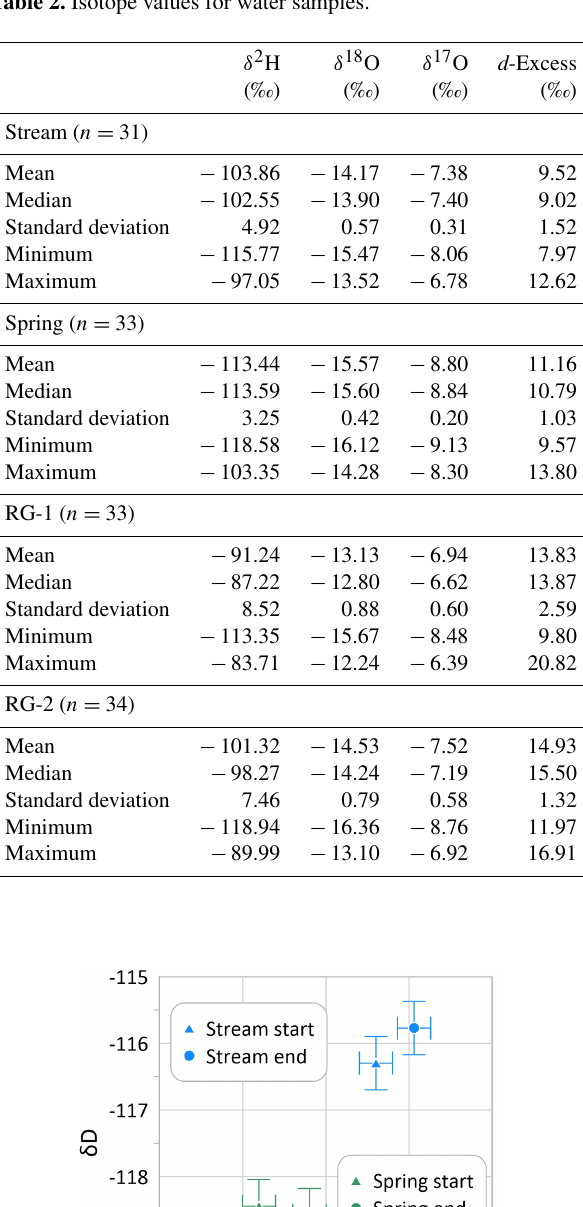
Table 2. Isotope values for water samples.